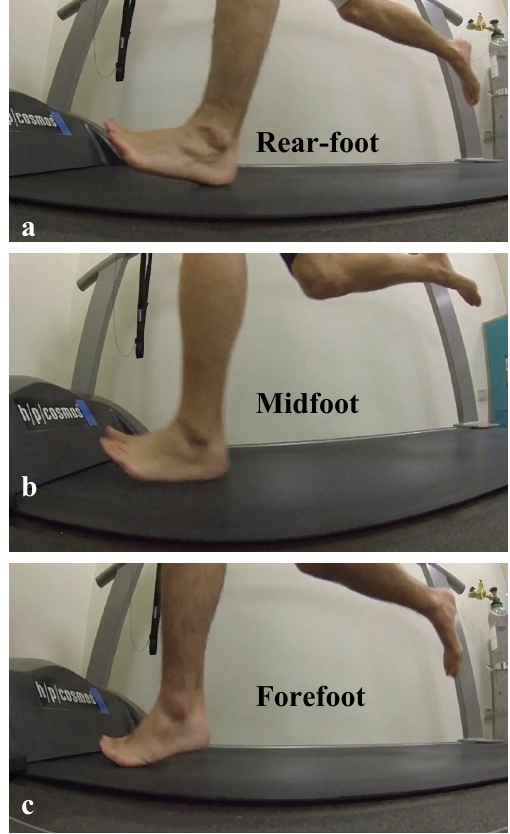
Figure 1. Three common types of landing pattern while running. ( a ): rearfoot strike (RFS), ( b ): midfoot strike (MFS), ( c ):forefoot strike